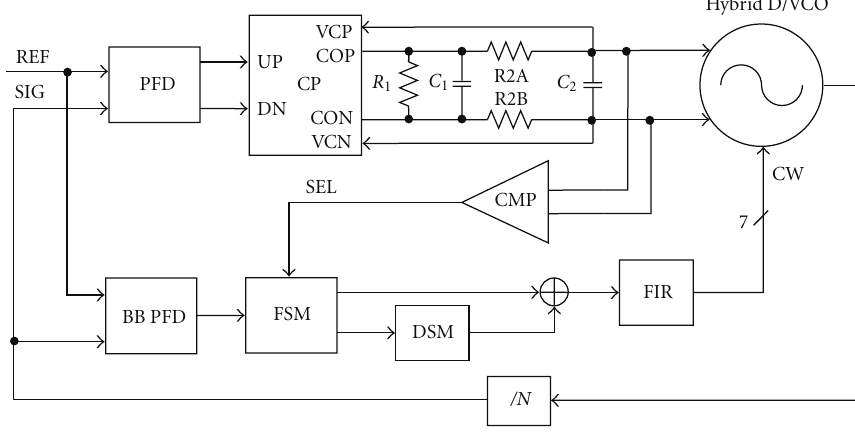
Figure 8: SDPLL block diagram.